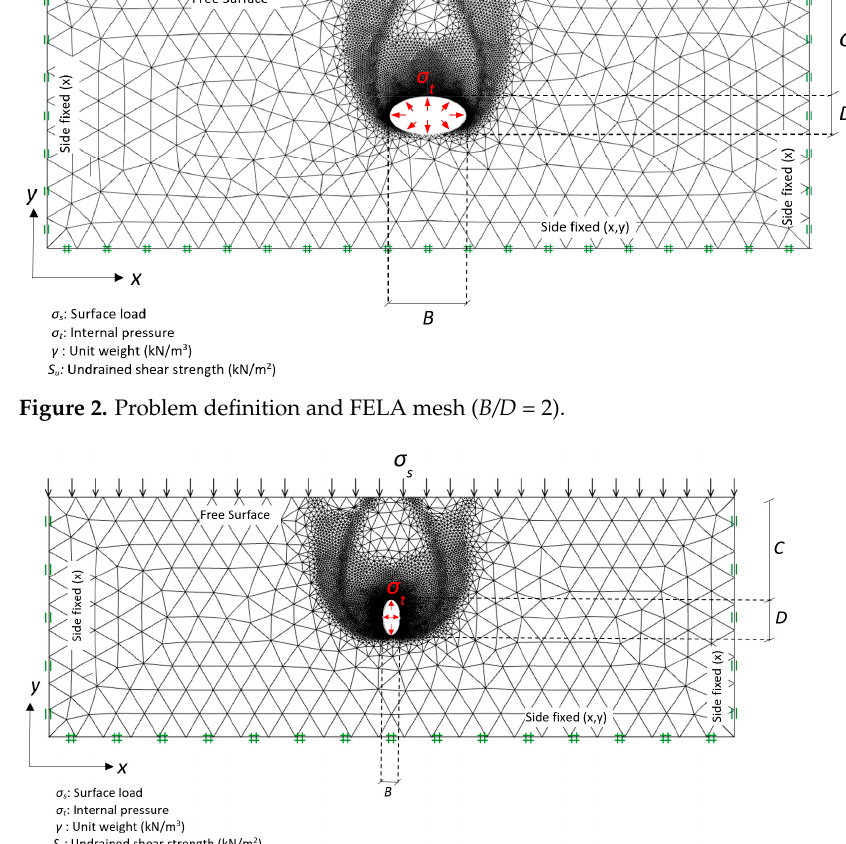
Figure 3. Problem definition and FELA mesh ( B/D = 0.5).